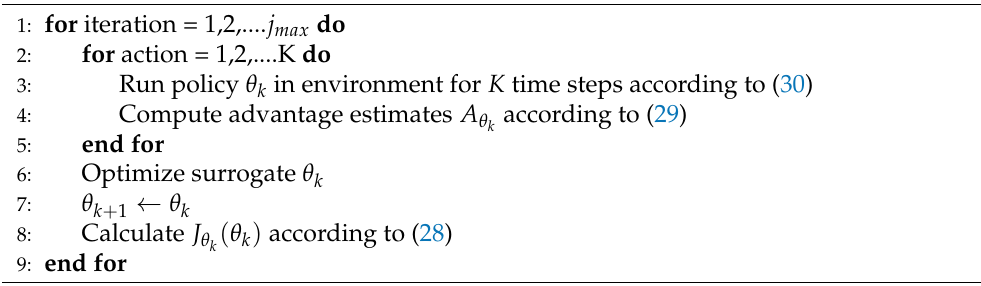
Algorithm 1 The Proximal Policy Optimization Algorithm